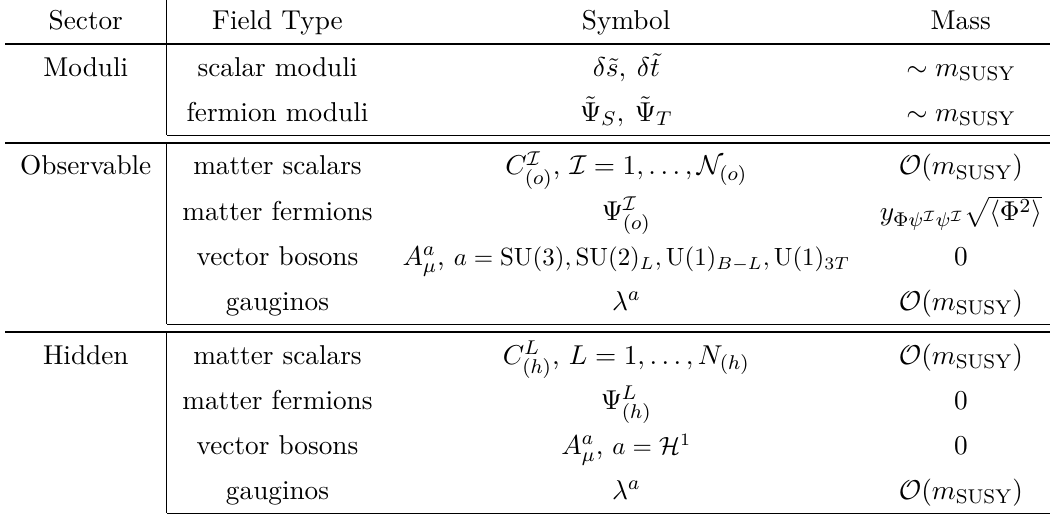
Table 1. Expected mass terms after 4D N = 1 supersymmetry is broken softly in the presence of one or multiple gaugino condensates on the hidden sector. The matter fermions and the gauge bosons do not obtain any mass contributions as a direct result of supersymmetry breaking. The rest of the fields from the observable and hidden sectors, obtain masses within the same magnitude range, O ( m ) , which in our model is required to be around 10 13 GeV. The masses of the moduli SUSY scalars and fermions are also proportional to m . In general, the values moduli masses are also SUSY of the same order as m , but it is easily possible to find cases in which they are significantly SUSY smaller, for specific non-perturbative